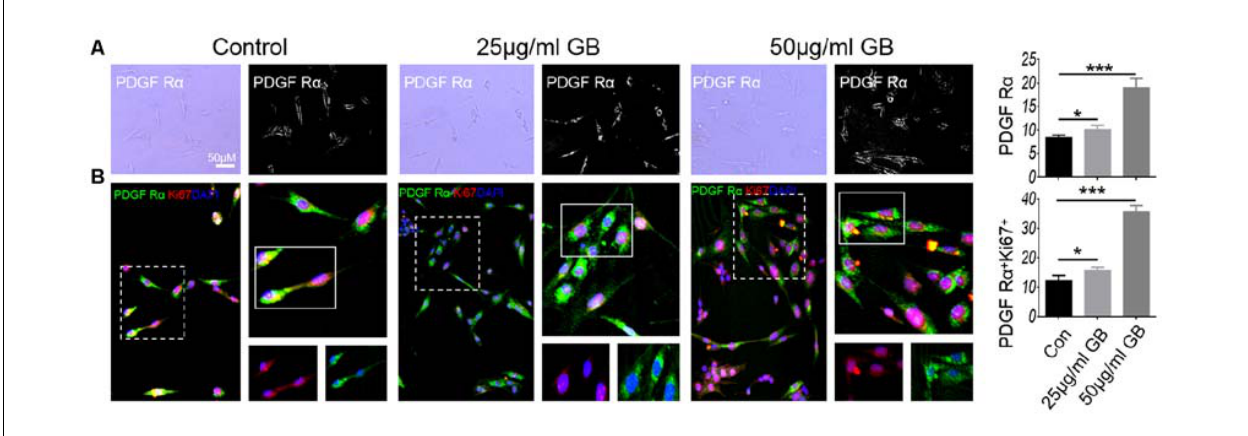
FIGURE 10 | GB (both 25 µ g/ml and 50 µ g/ml) promoted the generation of PDGFR α OPCs. (A) Bright field: PDGFR α . (B) Double immunocytochemistry staining with anti-PDGFR α and anti-Ki67 in the PDGFR α by immunocytochemistry. Representative images are obtained from three replicate samples/each group, with similar results. The results represent the mean ± SEM. ∗ p < 0.05, ∗∗∗ p <